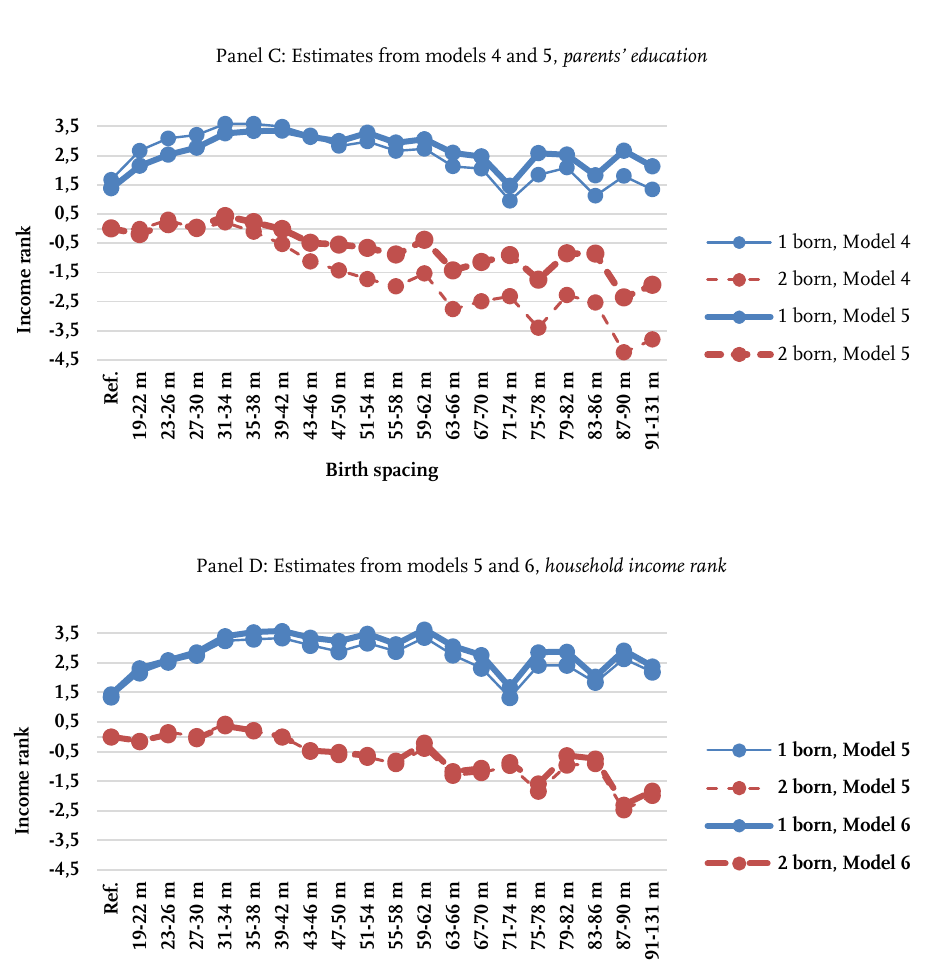
Figure 2 : Income rank across birth spacing intervals (continued) Panel C: Estimates from models 4 and 5, parents’ education